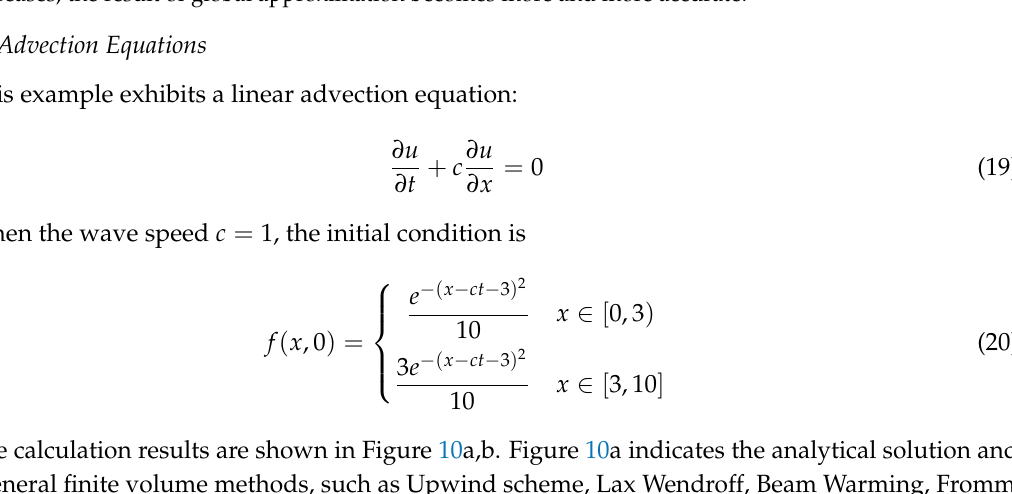
Figure 9. In the case of the same number of mathematical patches, as the order of local approximation increases, the result of global approximation becomes more and more accurate.